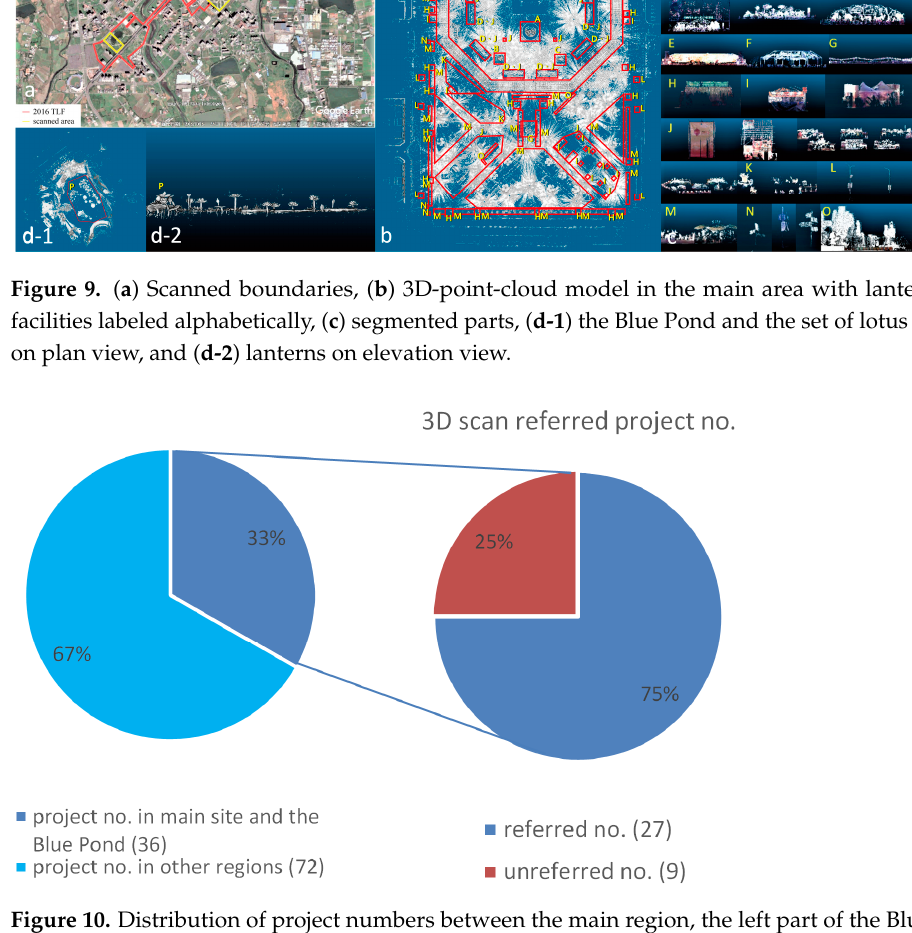
Figure 10. Distribution of project numbers between the main region, the left part of the Blue Pond, and the other areas ( left ); and tender projects identified from the 3D-point-cloud model ( right ).